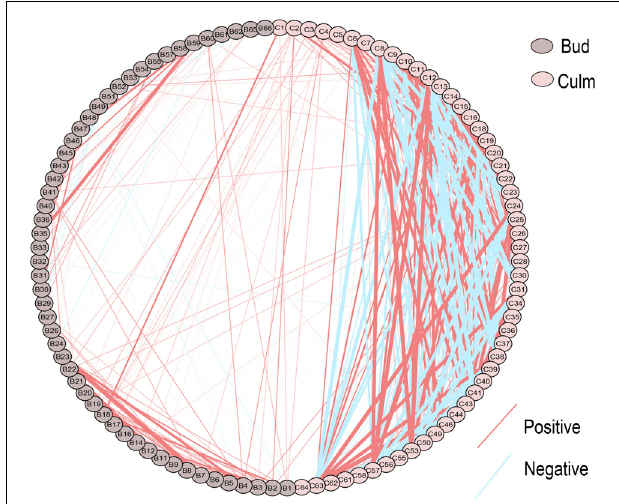
FIGURE 2 | Metabolite–metabolite correlations within and between tissues in different sugarcane commercial cultivars. Metabolites are indicated by codes available at the Supplementary Table S2 . Positive and negative correlations are represented in red and blue, respectively. Different color of nodes denotes distinct